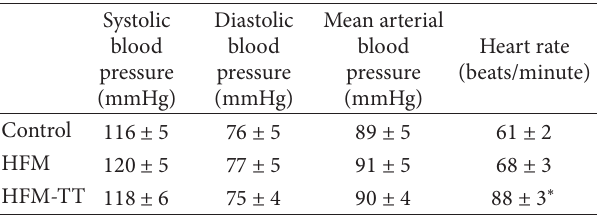
Table 2: Blood pressure and heart rate data. There were no differences in any of the blood pressure values between the three trials. HFM: high fat meal trial; HFM-TT: high fat meal plus thermotherapy trial. Values are means ± SEM. ∗ 𝑃 < 0.05 versus control and HFM conditions.